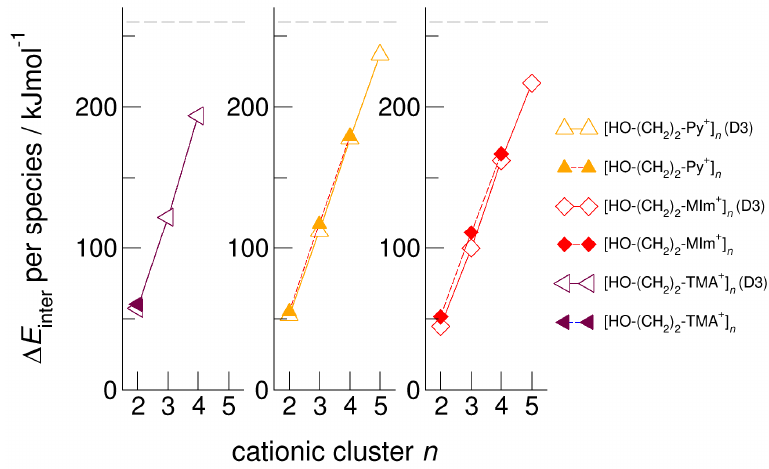
Figure 4. Intermolecular energies per species in the cationic clusters [HO-(CH 2 ) 2 -TMA + ] n , [HO-(CH 2 ) 2 -Py + ] n , and [HO-(CH 2 ) 2 -MIm + ] n calculated at the B3LYP/6–31+G* level of theory with (open symbols) and without (filled symbols) dispersion correction. The dashed grey lines indicate meta-stability of the cationic clusters with energies below 260 kJ mol − 1 per cation. Beyond this energy, the cationic clusters undergo “Coulomb explosion” and dissociate [59].